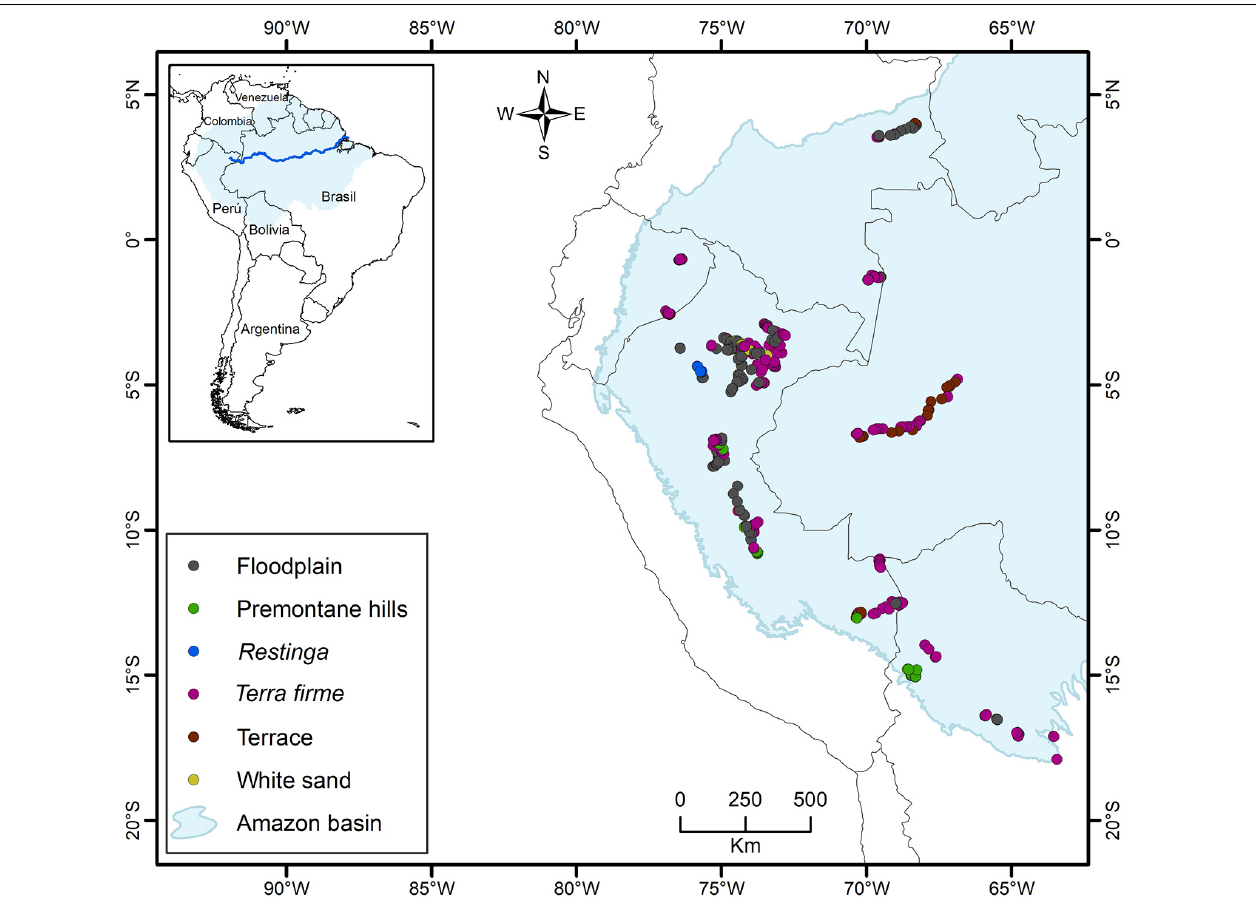
FIGURE 1 | Location of the 458 transects (500 × 5 m) sampled in the western Amazonia, with indication of the forest types. In the analysis in this paper the data from Restinga, Terra firme, and Terrace are combined into the category Non-flooded